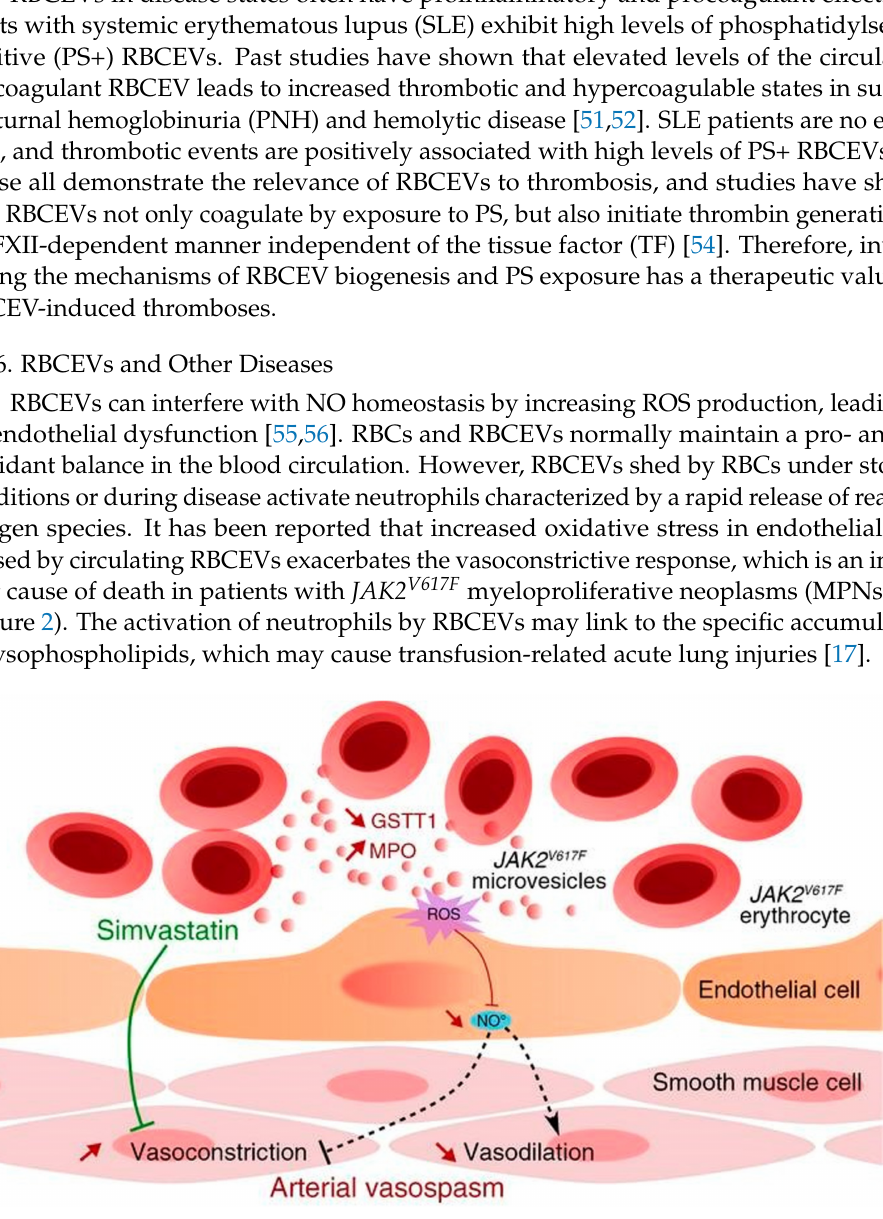
Figure 2. RBCEVs are associated with increased arterial constriction in Bcr/Abl-negative myelopro- liferative neoplasms (MPNs) as RBCEVs carry MPO, which provides a prooxidant phenotype in endothelial cells, resulting in an increased arterial constriction. Reprinted with permission from